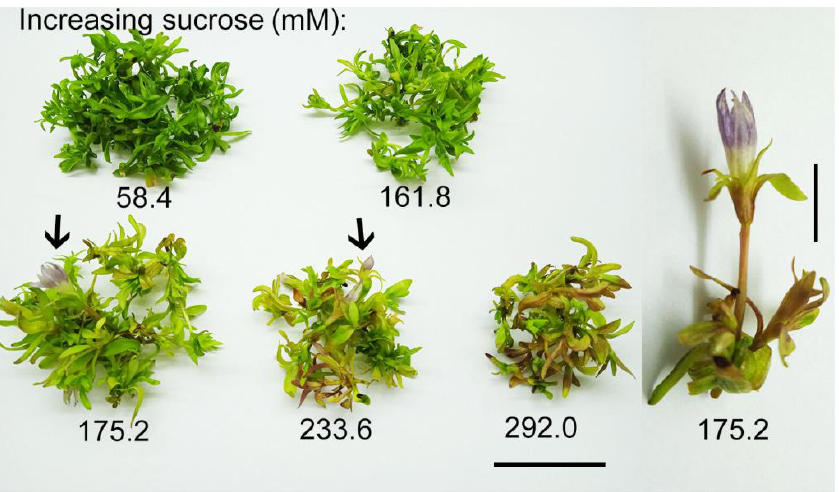
Figure 7. The effect of sucrose at increasing concentrations (58.4, 161.8, 175.2, and 233.6 mM) on the growth and flowering of shoot cultures of G. lutescens (line 5) after 35 days of culture ( bar = 20 mm). The increasing concentrations of sucrose were added into control medium (BM + 0.2 mg L −1 BA containing 58.4 mM sucrose). Arrows indicate floral bud development. Right—shoot with normally developed flower regenerated on the medium with 175.2 mM sucrose ( bar = 5 mm).